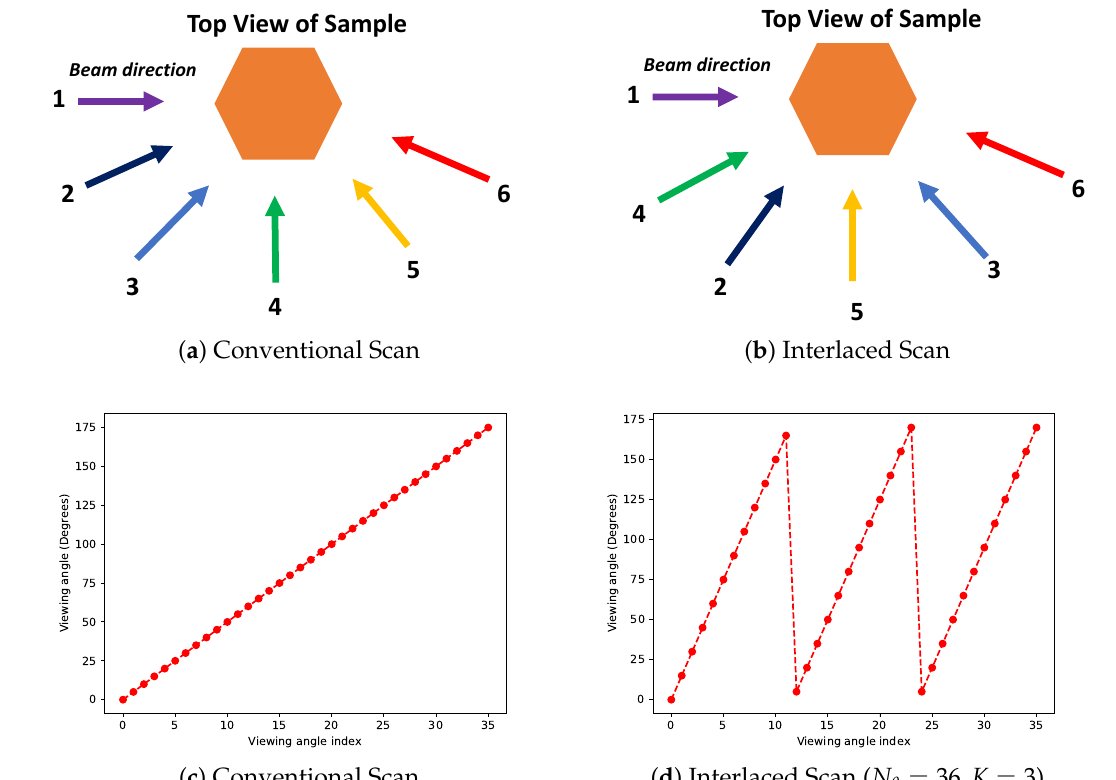
Figure 2. Illustration of two ways to acquire tomographic datasets. ( a ) Representation of the conventional scanning protocol using 6 equally spaced angles between 0 ◦ and 180 ◦ . ( b ) Example of one realization of the proposed interlaced scanning protocol that ensures subsequent measurements are far apart ( K = 2, N θ = 6 in Equation (1)). List of view angles using ( c ) the conventional approach and ( d ) one realization of the interlaced scan that was used in the experiments in this paper ( K = 3, N θ = 36). The advantage of the interlaced scan is that at any given point during the course of the experiment, the object is scanned fairly uniformly, thereby enabling reconstructions with fewer artifacts that the end users can utilize to make decisions. The parameters of the interlaced scan can be further adjusted so that subsequent measurements are maximally separated (not shown